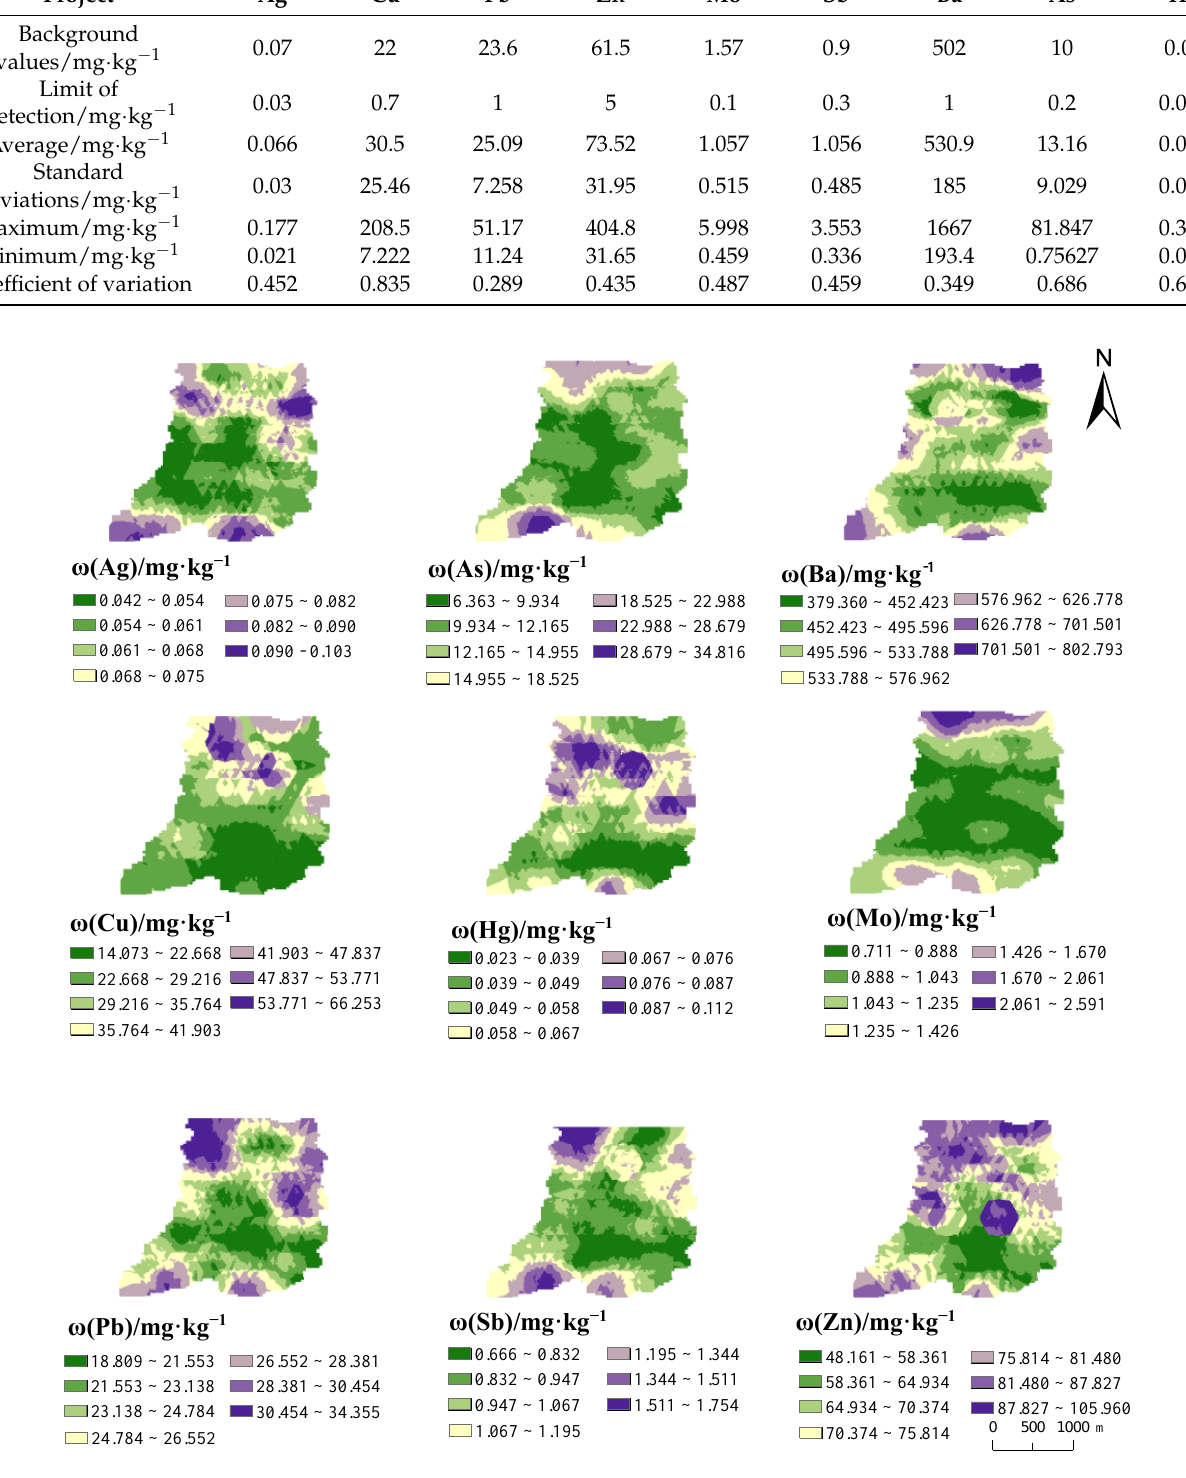
Figure 2. Spatial distribution of potentially toxic elements content in soil of the study area.